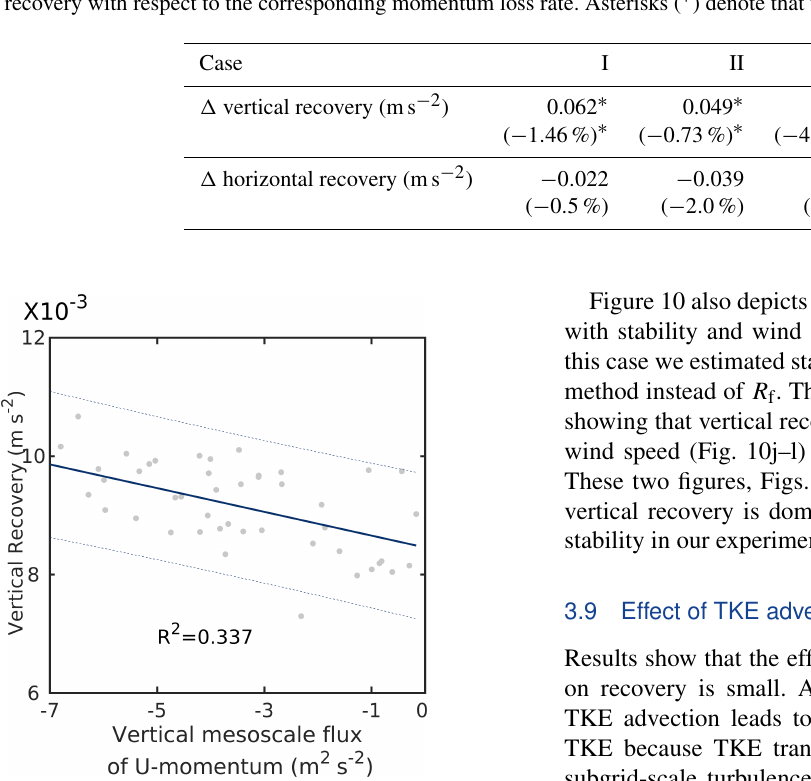
Figure 8. Scatterplot of averaged vertical recovery (at hub height) and averaged vertical mesoscale flux of u momentum (integrated between 1000–2500m) for case C-I. The values are averaged over the wind farm. The solid blue line shows the best fit, and the dashed blue lines show the 95% prediction